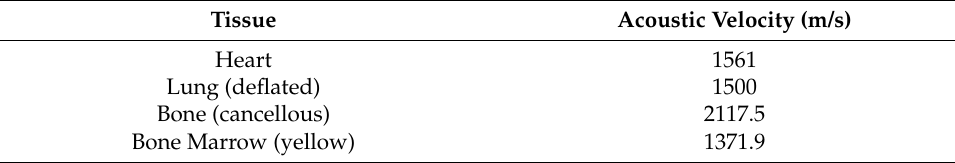
Table 1. The acoustic velocity of primary tissues in the thorax